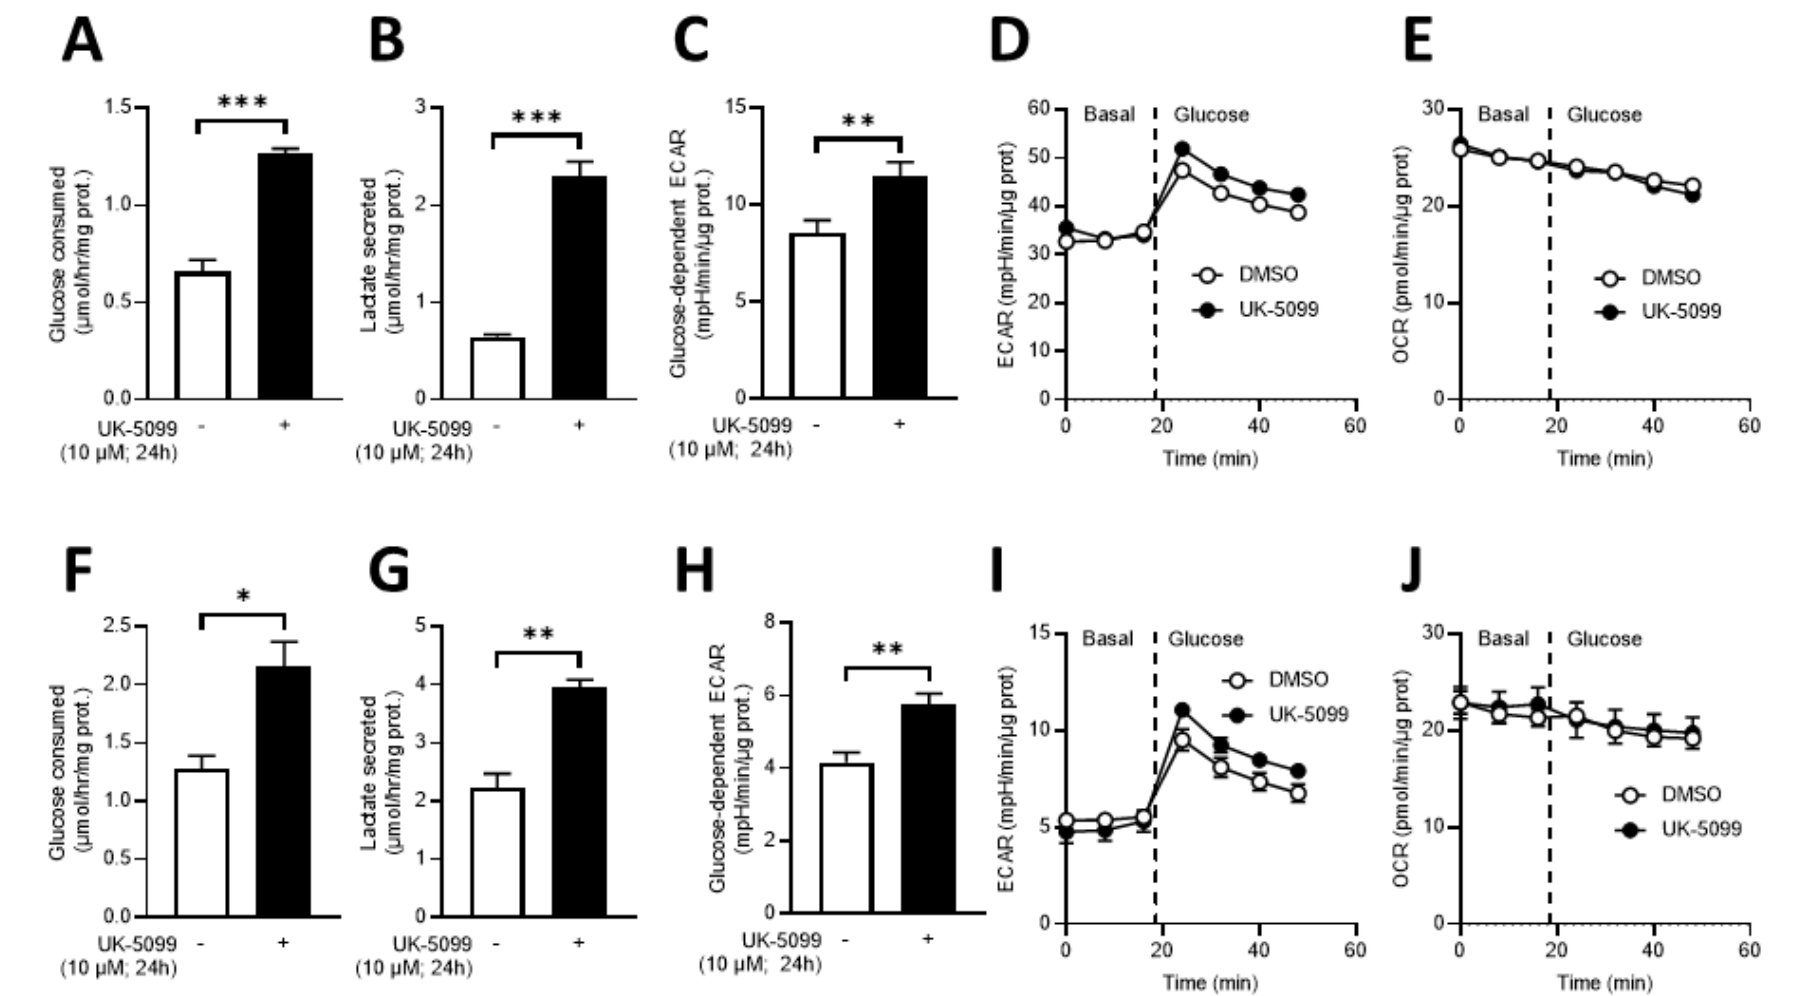
Figure 4. Impact of UK-5099 on metabolic parameters. SiHa (top, ( A – E )) and 4T1 (bottom, ( F – J ) ) cells were treated for 24 h with 10 μM UK-5099 in glucose-containing medium. Effect of treatment on glucose consumption ( A , F ), lactate release ( B , G ), extracellular acidification rate (ECAR) ( C , H ), time course of extracellular acidification ( D , I ) and oxygen consumption rate (OCR) ( E , J ). * p < 0.05; ** p < 0.01; *** p < 0.001.